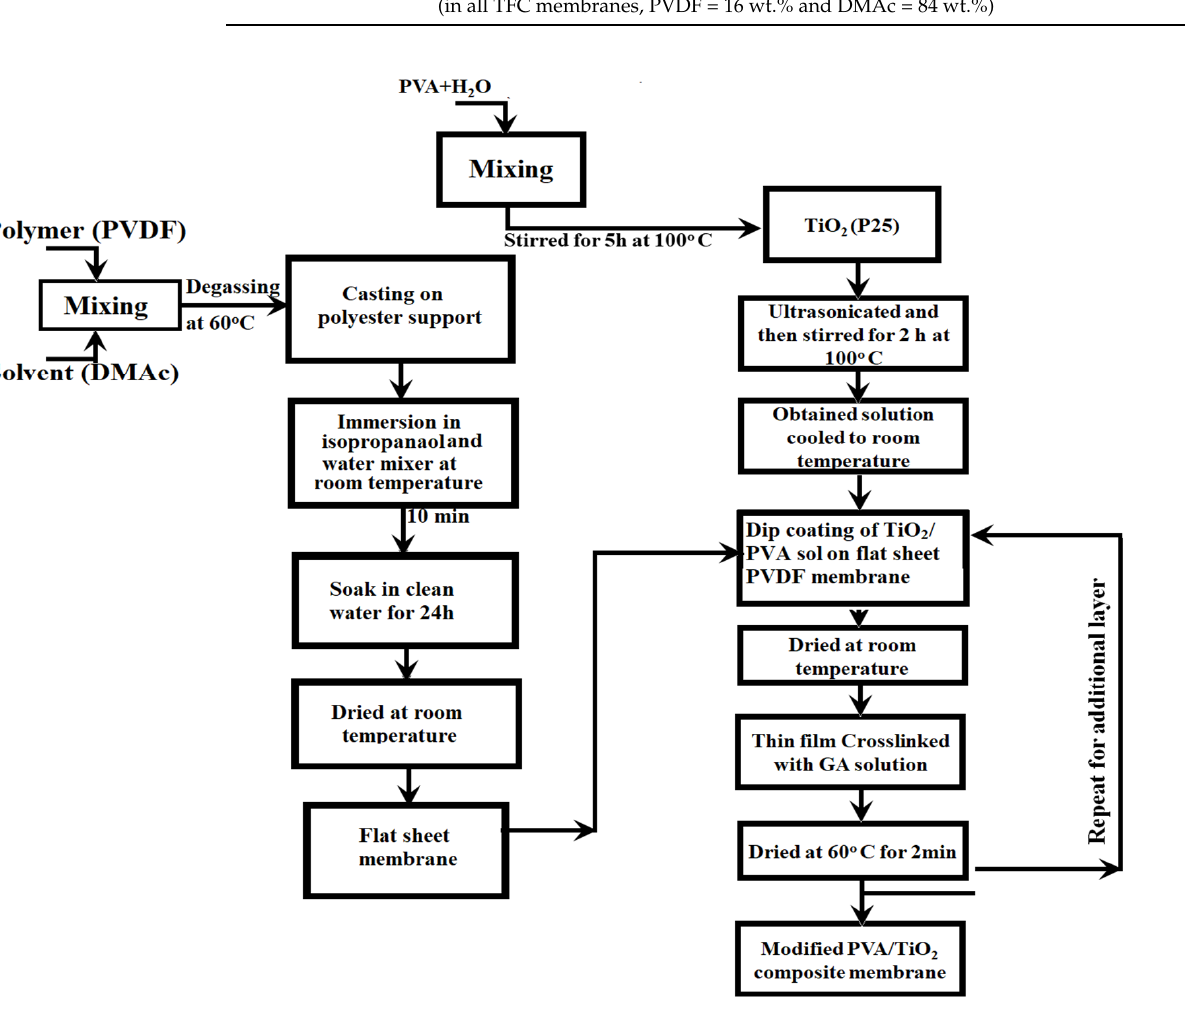
Figure 1. Preparation and synthesis flow diagram for the synthesis of TFC TiO 2 /PVA/ PVDF membrane .